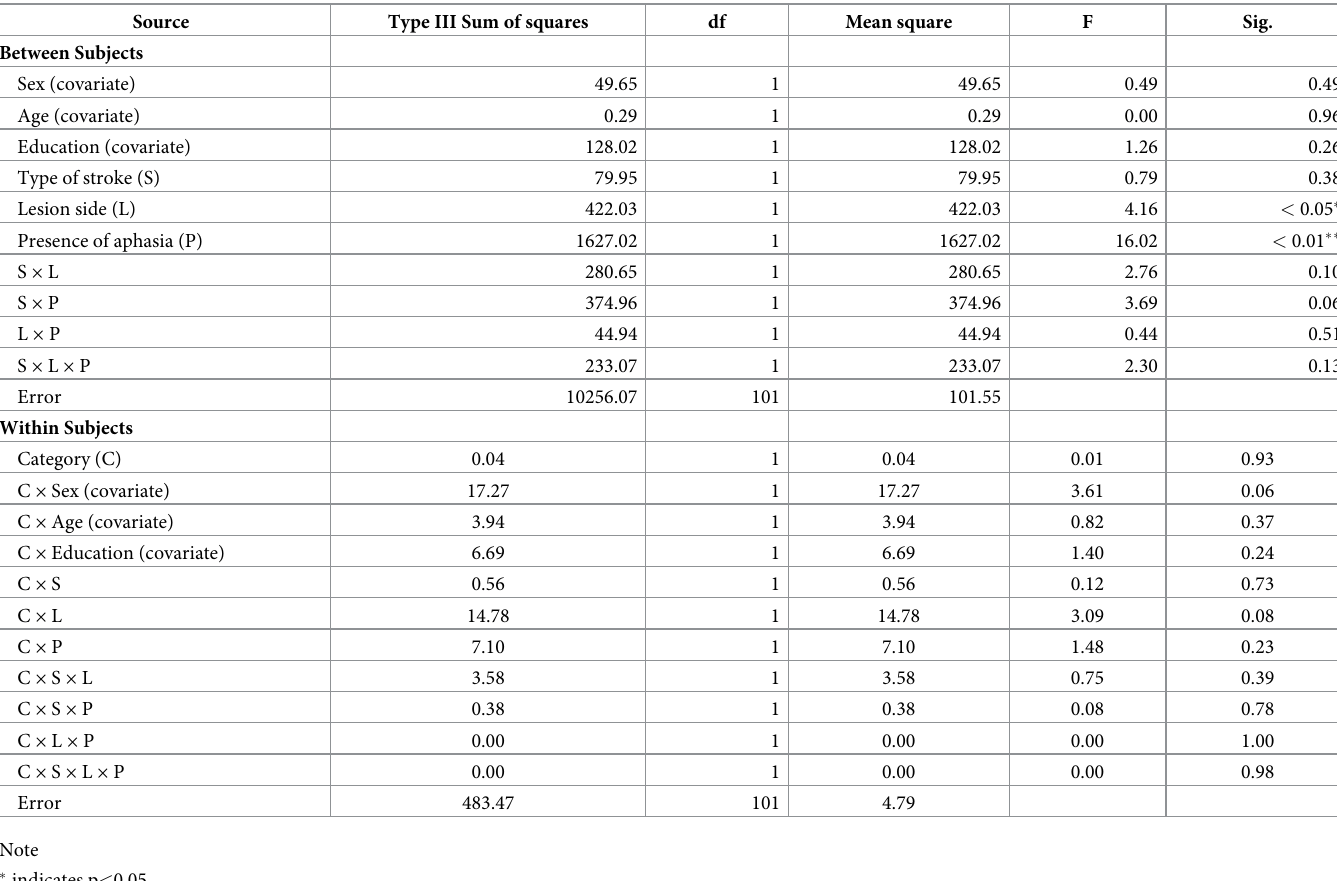
Table 5. Mixed ANCOVA results for category effect (living objects vs. artificial objects) in stroke patients (N = 112).